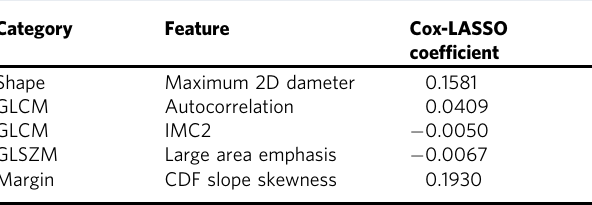
Table 1 Radiomics risk score model for prognosis and the associated radiomics